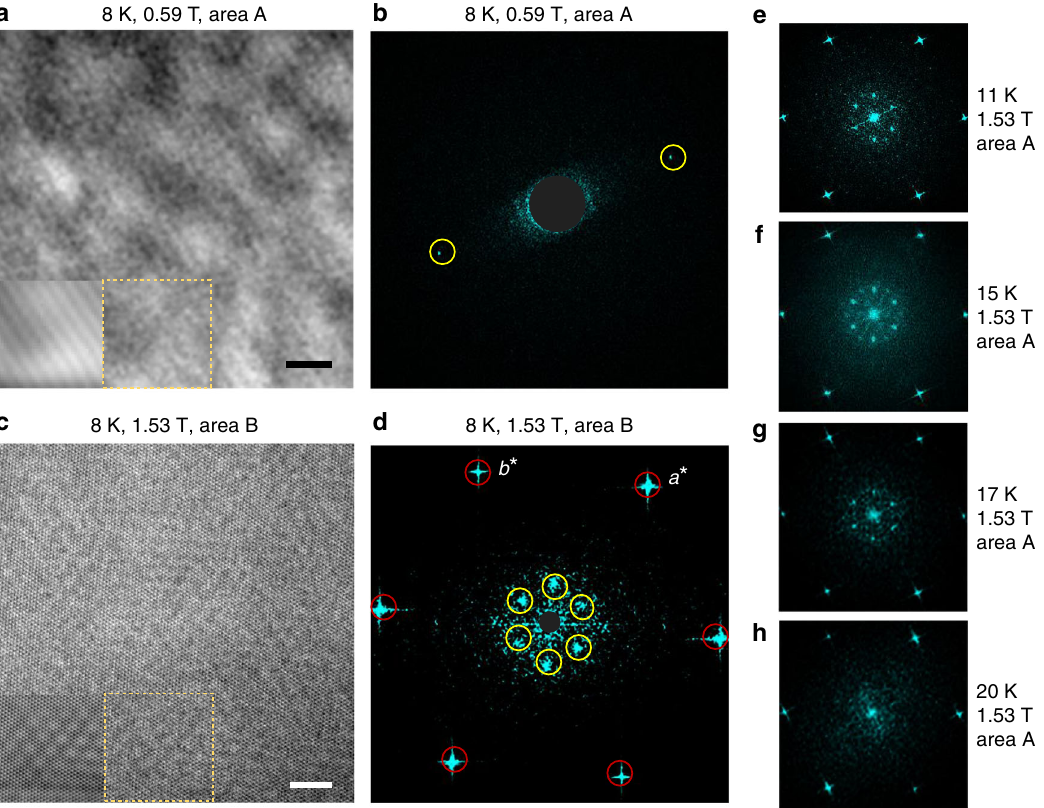
Fig. 4 Real-space observations of helical stripes and SkL in a (001) thin-plate sample of Gd 3 Ru 4 Al 12 using Lorentz-transmission electron microscopy (L-TEM). We report data obtained from two different areas A, B of the same thin plate. The magnetic fi eld was applied perpendicular to the sample plane. All data were recorded under fi eld cooling (FC) conditions. a * and b * are crystalline axes in reciprocal space. Fast Fourier transform patterns in b , d correspond to real-space images (underfocused L-TEM images) shown in a and c , respectively. The defocusing length of the electron beam was l d = − 3 μ m ( a , b ) and l d = − 193 nm ( c – h ). In ( b ), the scale of the data was magni fi ed as compared to ( d ), cutting the featureless high- q regime for clarity. Red (yellow) circles in ( b , d ) mark intensity due to the crystal lattice (the magnetic order). Focusing on representative parts of the real space image (yellow dashed box), fi ltered images are shown as insets in ( a , c ) (same length scale as main panel). Helical stripes ( T = 8 K, μ μ H = 1.53 T, μ H = 1.95 T) are visible in the data. e – h T -dependence of the fast Fourier transform patterns of the magnetic and lattice images at 1.53 T. 0 int 0 The magnetic contrast of the SkL is suppressed above T = 17 K. See Methods for fi ltering procedure and other experimental details. Scale bars in panels ( a , c ) correspond to 10